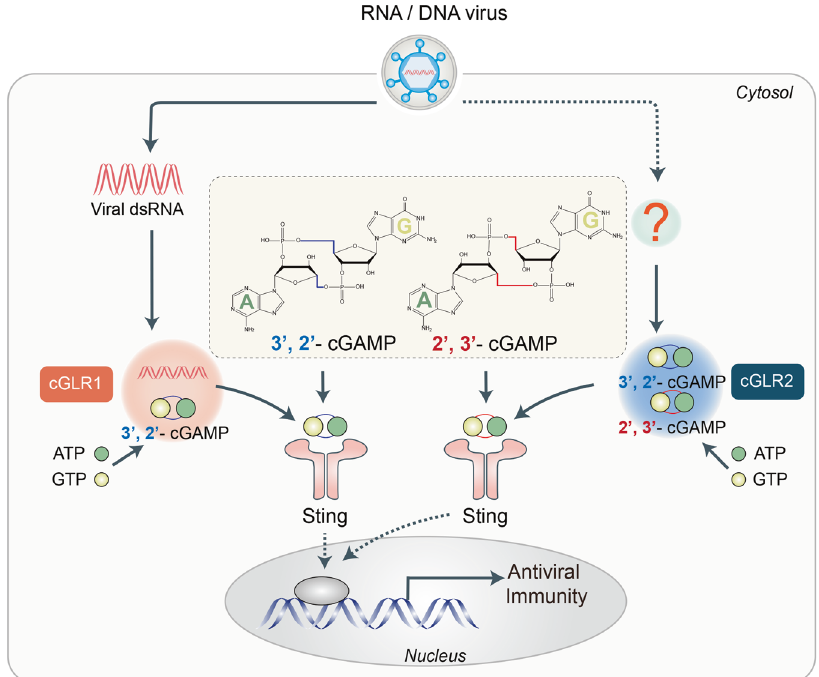
Fig. 1 Functions of cGAS-like receptors (cGLRs) in Drosophila immune responses. cGLR1 and cGLR2 are two cGLRs in Drosophila, cGLR1 can response to RNA/DNA virus, while cGLR2 is not de fi nite. The details of DNA virus activating cGLRs are not clear. cGLR1 requires dsRNA to be activated and synthesize 3 ʹ 2 ʹ -cGAMP as a second messenger. The ligand of cGLR2 is unknown, while it can trigger antiviral immunity through synthesizing 3 ʹ 2 ʹ -cGAMP and 2 ʹ 3 ʹ -cGAMP. Sting-dependent pathway is activated after combining the second